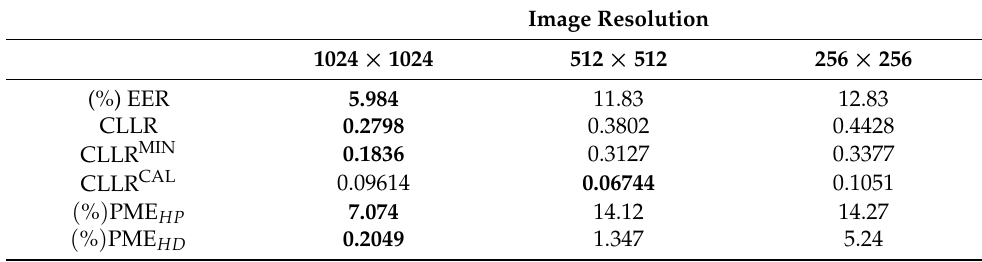
Table 2. Performance metrics observed for different resolutions of the images. The best performance is highlighted in